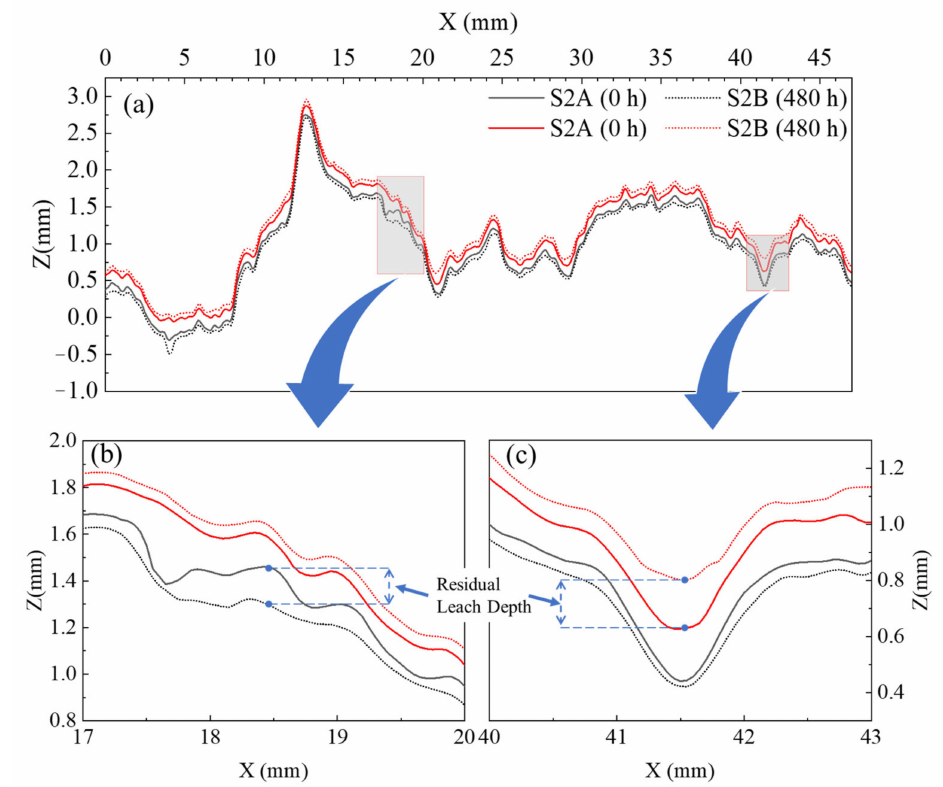
Figure 14. Temporal evolutions in profile variation. ( a ) profile of Y = 10 mm, ( b ) enlarged view of X = 17 − 20 mm and ( c ) enlarged view of X = 40 − 43 mm.